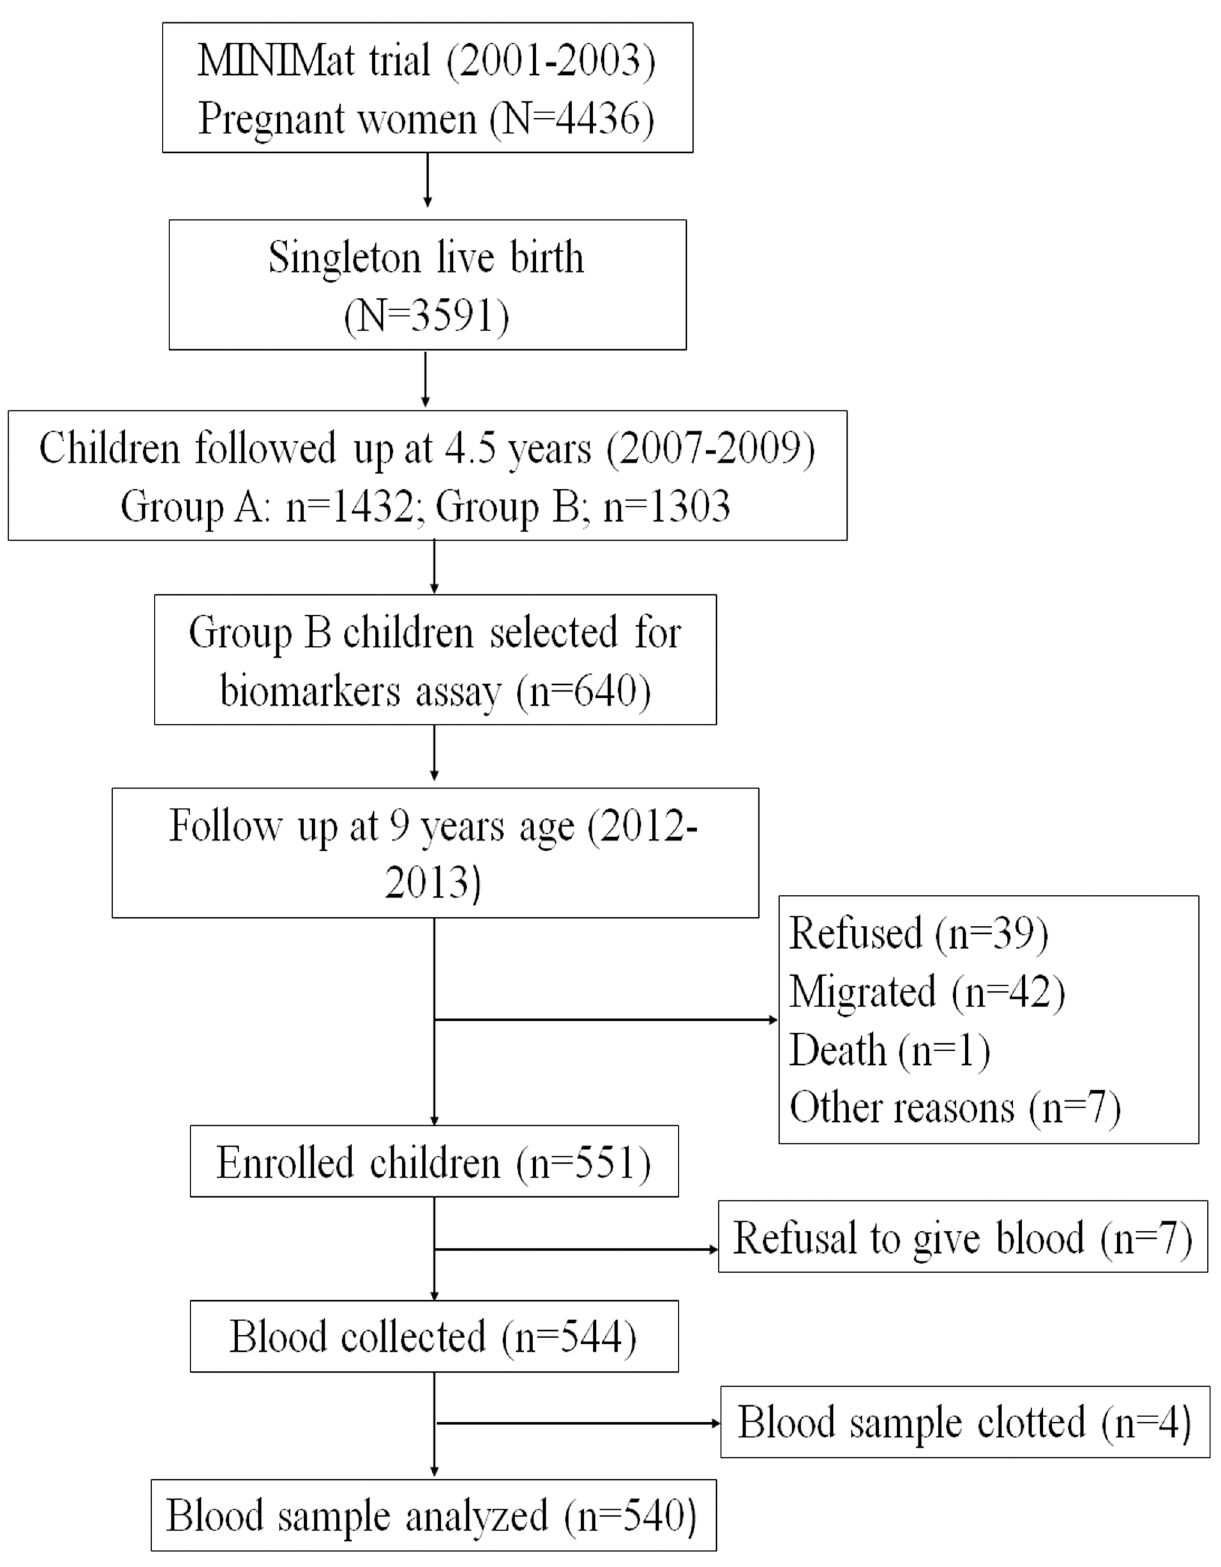
Fig 1. Flow chart describing the enrolment of the children in the current study. The group A children (n = 1432) were born between April 2002 to May 2003 and group B (n = 1303) were born between June 2003 to June 2004. doi:10.1371/journal.pone.0161294.g001 PLOS ONE | DOI:10.1371/journal.pone.0161294 August 18,